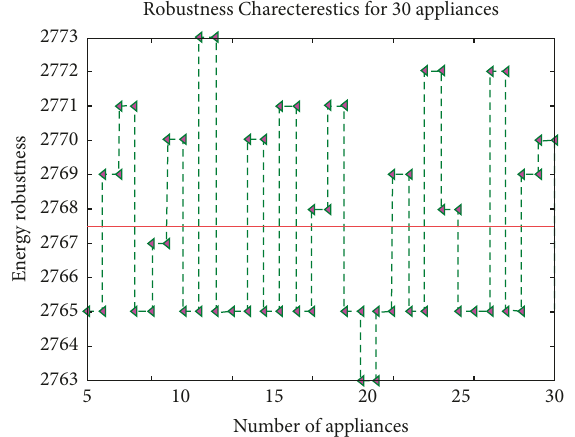
Figure 12: Comparison of robustness characteristics.